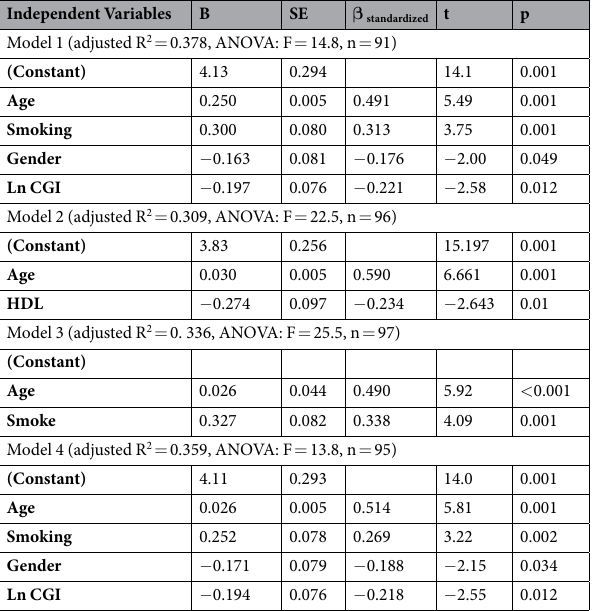
Table 4. Summary of results from linear regression analyses on natural logarithm (ln) of plasma GDF15 levels. CGI: Clinical Global Impression-Severity. HDL: